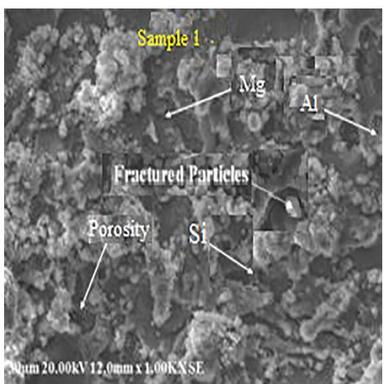
CAST MMNC Sample S1 at 30 mm Scale Range.